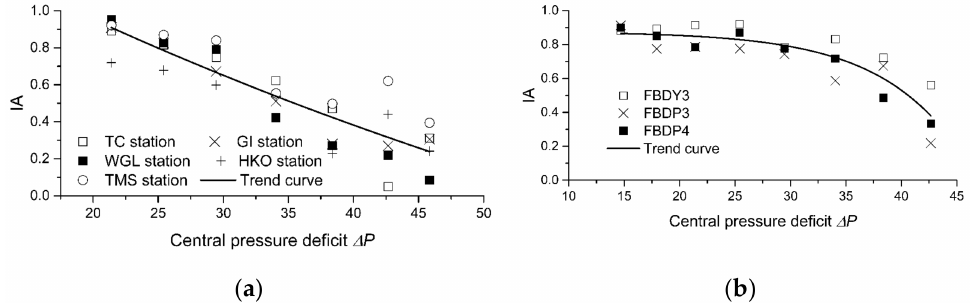
Figure 6. Wind speed error variation as a function of the ∆ P. ( a ) IA of wind speed over land; ( b ) IA of wind speed over the sea.